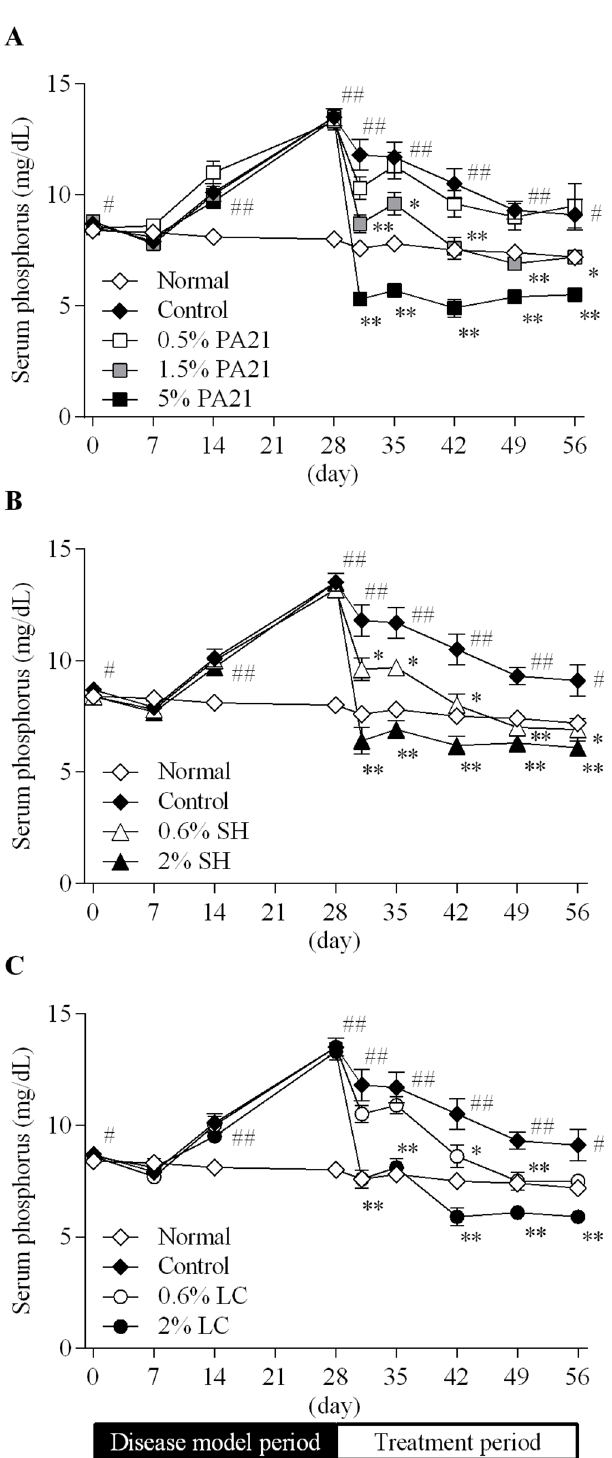
Fig 2. The effects of (A) PA21, (B) sevelamer hydrochloride, and (C) lanthanum carbonate hydrate on serum phosphorus level. At day 29, administration of the investigateddrugs was started. Each dot in the figures shows the mean value ± standard error of eight to 10 animals. SH, sevelamerhydrochloride; LC, lanthanum carbonate hydrate. # P < 0.05 and ## P < 0.01, Student’sor Aspin-Welch’st-test betweenthe normaland control groups. * P < 0.05 and ** P < 0.01, Dunnett’sor Steel’s multiple comparison tests between the control and the investigateddrug administered groups.